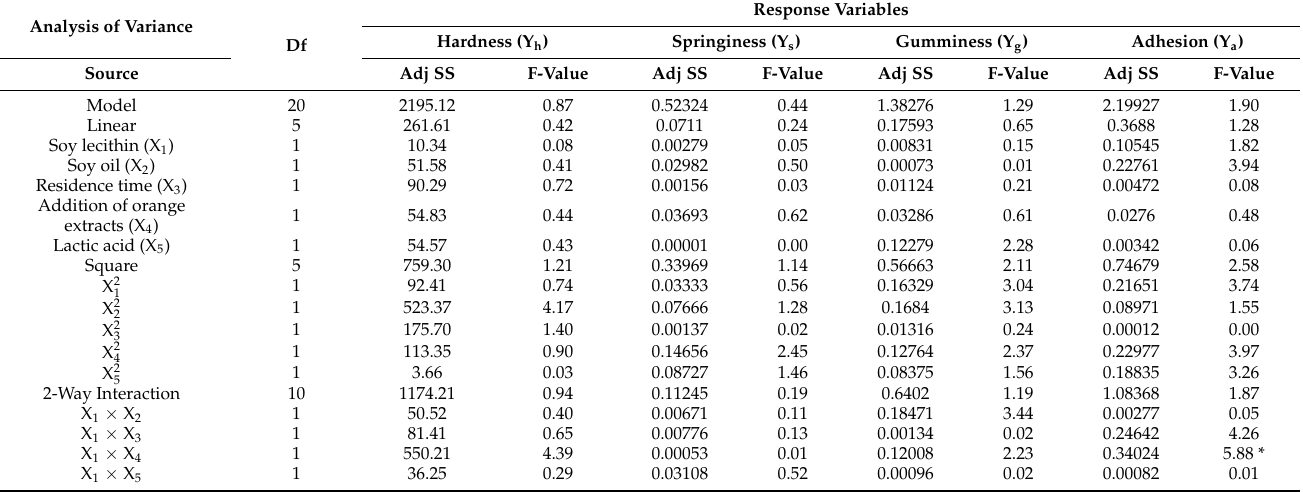
Table 3. Linear, quadratic, and interaction of the response variables of textural